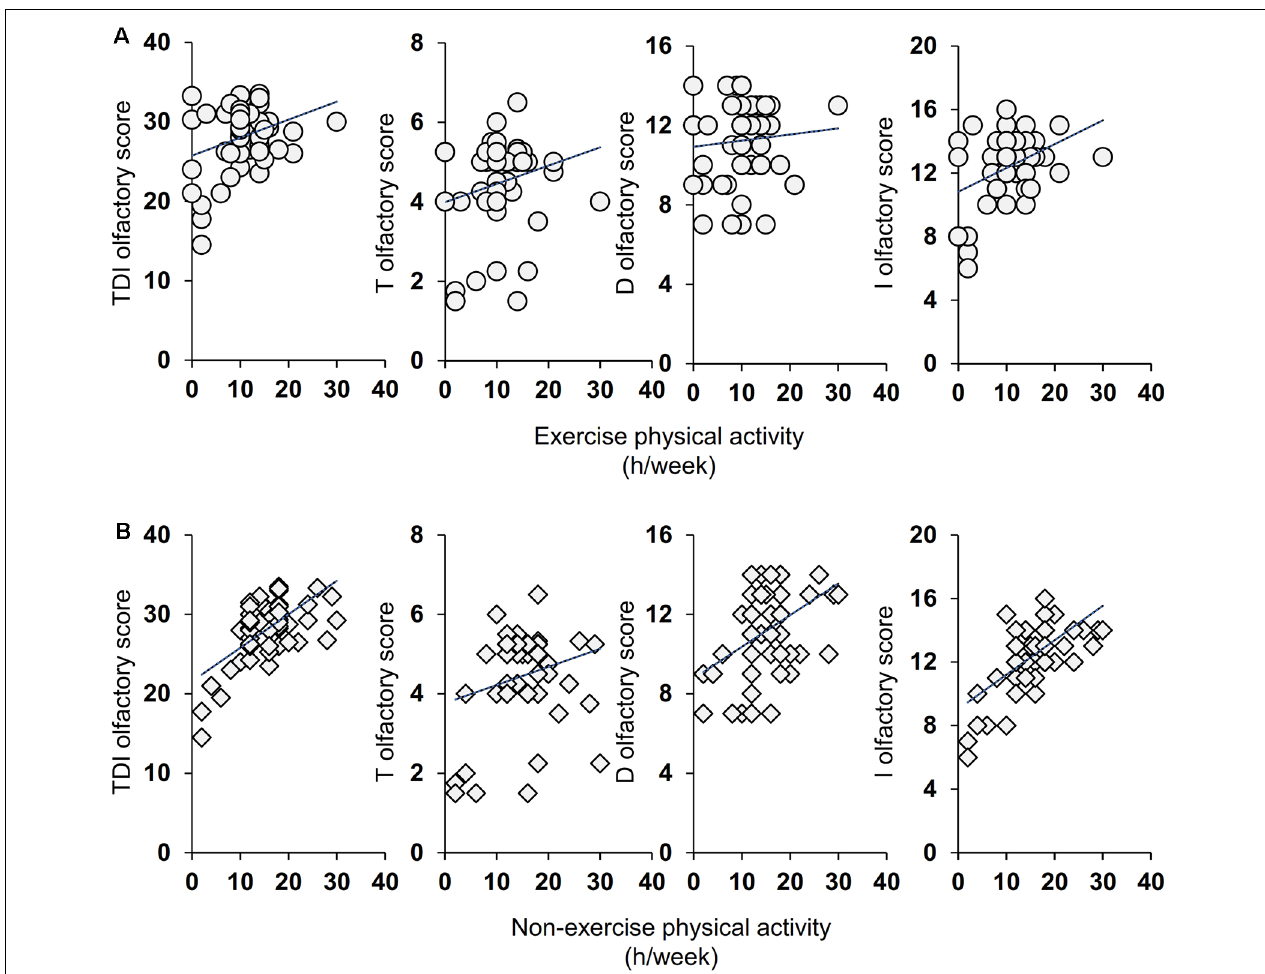
FIGURE 2 | Correlation analysis between the TDI, T, D, and I olfactory score and the number of hours per week (h/week) dedicated by each active elderly subjects (ES) to the exercise (A) and non-exercise (B) physical